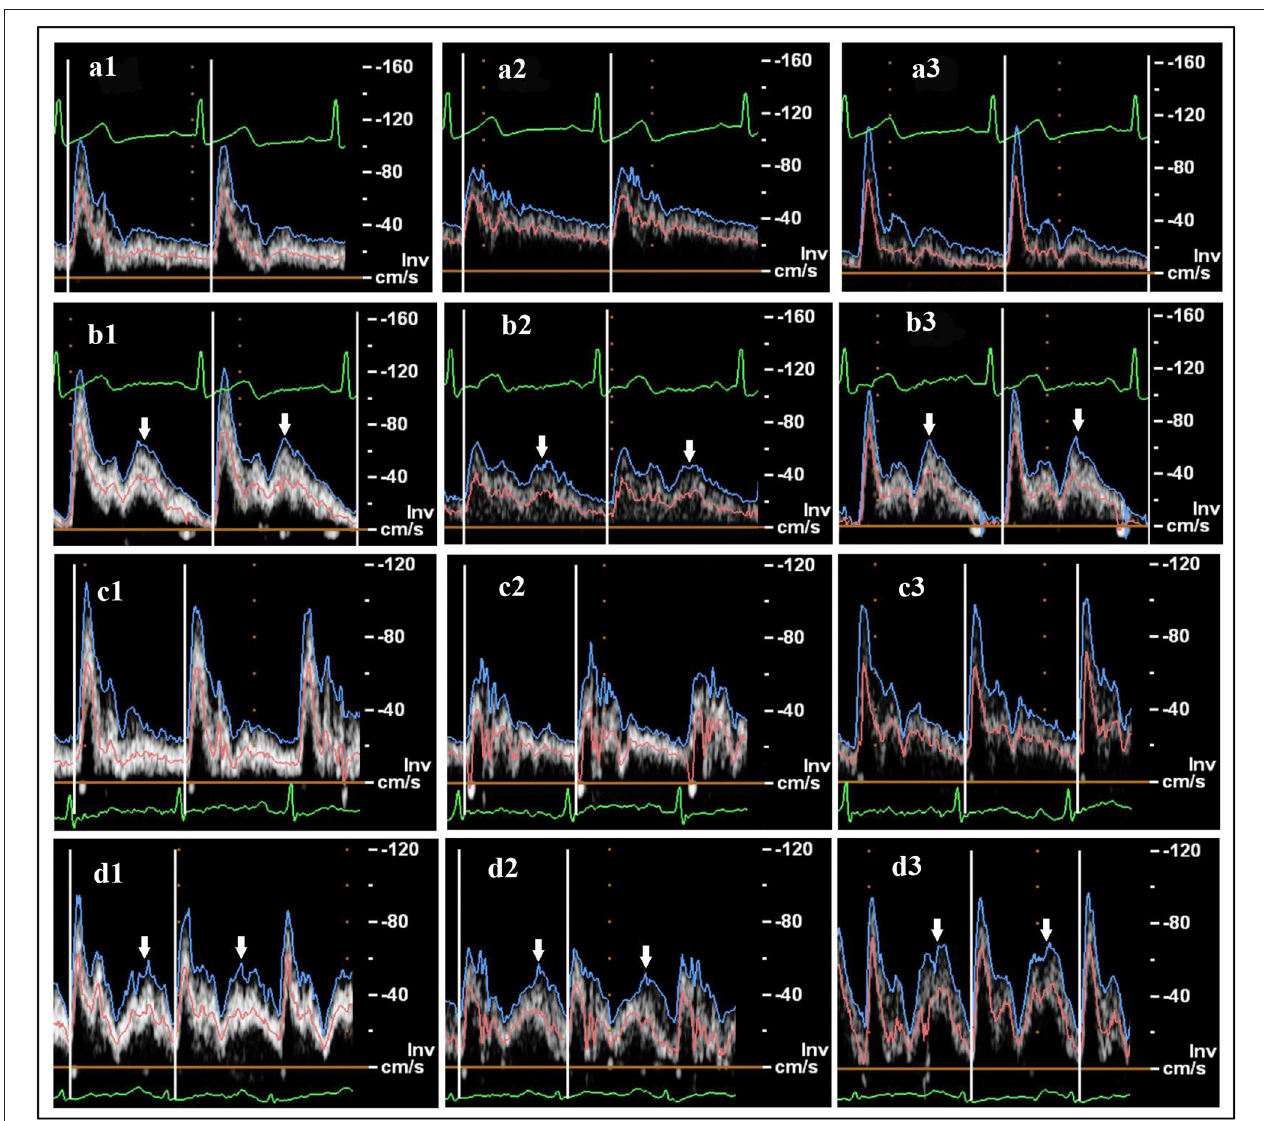
FIGURE 1 | Ultrasound flow velocity spectrum: (a) healthy subject, pre-enhanced external counterpulsation (EECP); (b) healthy subject during EECP with 30 kPa cuff pressure; (c) patient, pre-EECP; (d) patient during EECP with 30 kPa cuff pressure. Common carotid artery (CCA), internal carotid artery (ICA), and external carotid artery (ECA) are represented by 1, 2 , and 3 , respectively. The blue, pink, and green curves represent the peak flow velocity waveforms, mean flow velocity waveforms, and ECGs, respectively. White arrows indicate the diastolic increase induced by EECP stimulation.